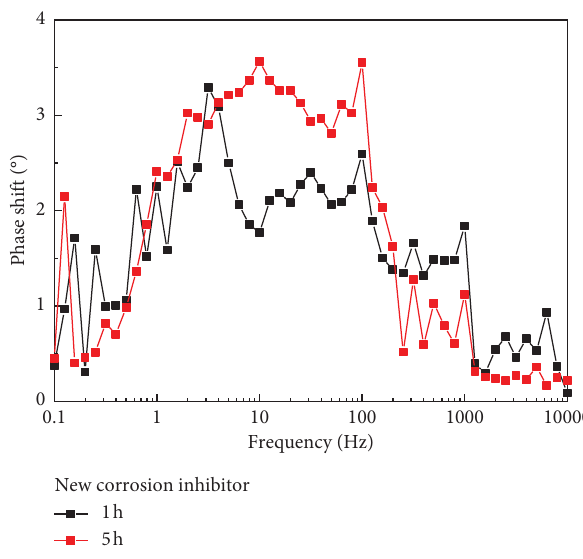
Figure 9: Bode plot with the phase shift in function of the loga- rithm of the